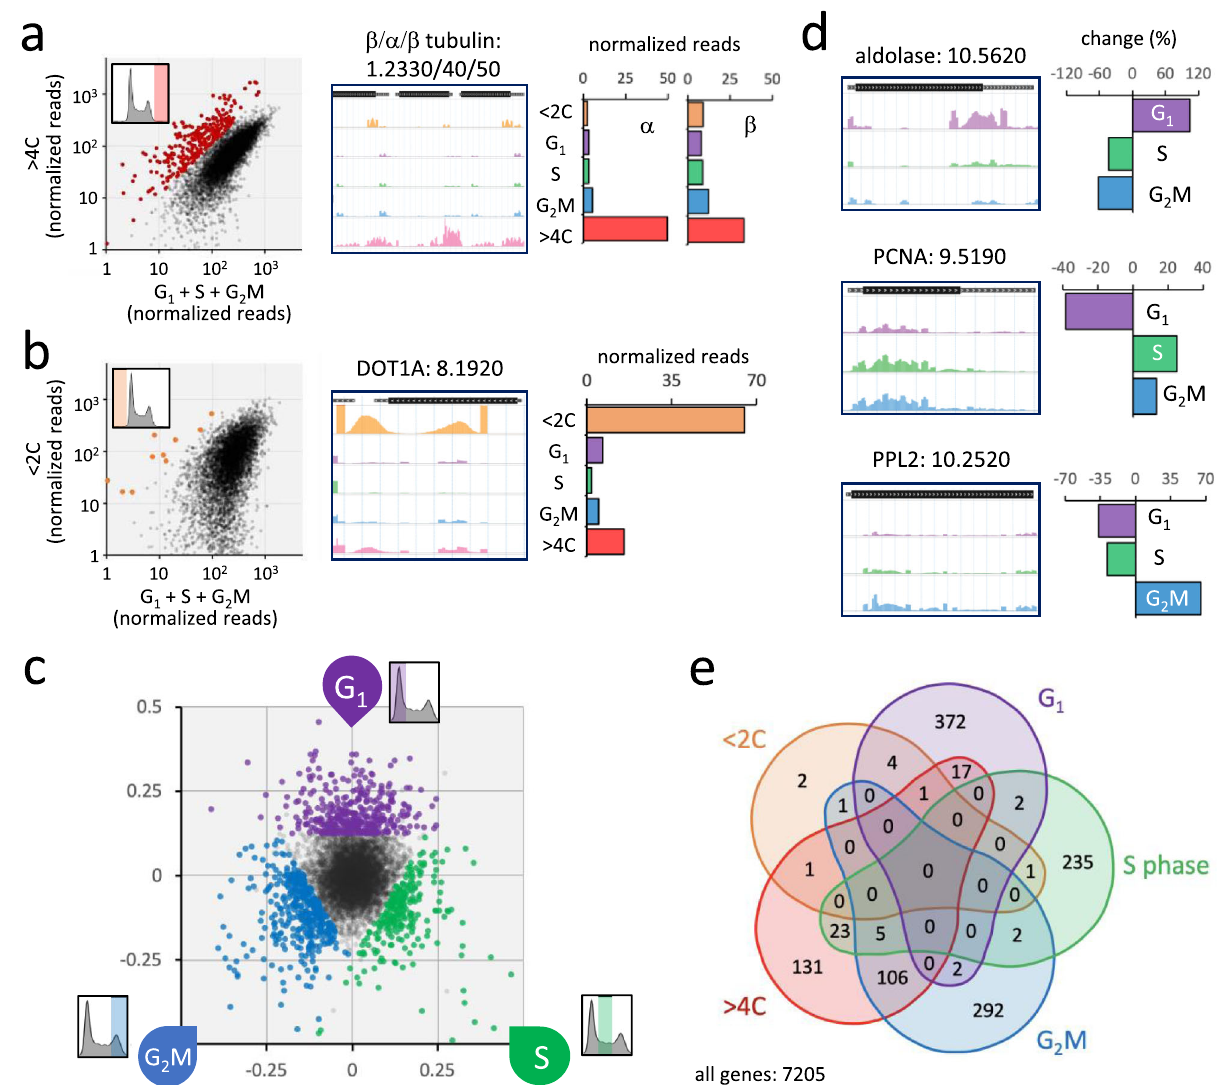
Fig. 2 | Validation and identi fi cation of >1000 candidates linked to cell cycle defects. a The plot on the left shows knockdowns overrepresented in the >4C experiment in red; those with reads in the >4C pool that exceeded the mean fold- changevalueby>1.75timestheSD,equivalentto>1.117-foldthesumofreadsinthe G 1 ,SphaseandG 2 Msamplescombined.Theread-mappingpro fi leandread-counts for α / β -tubulin are shown to the right. b The plot on the left shows knockdowns overrepresentedinthesub-2Cexperimentinorange;thosewithreadsinthesub-2C poolthatexceededthemeanfold-changevalueby>1.75timestheSD,equivalentto